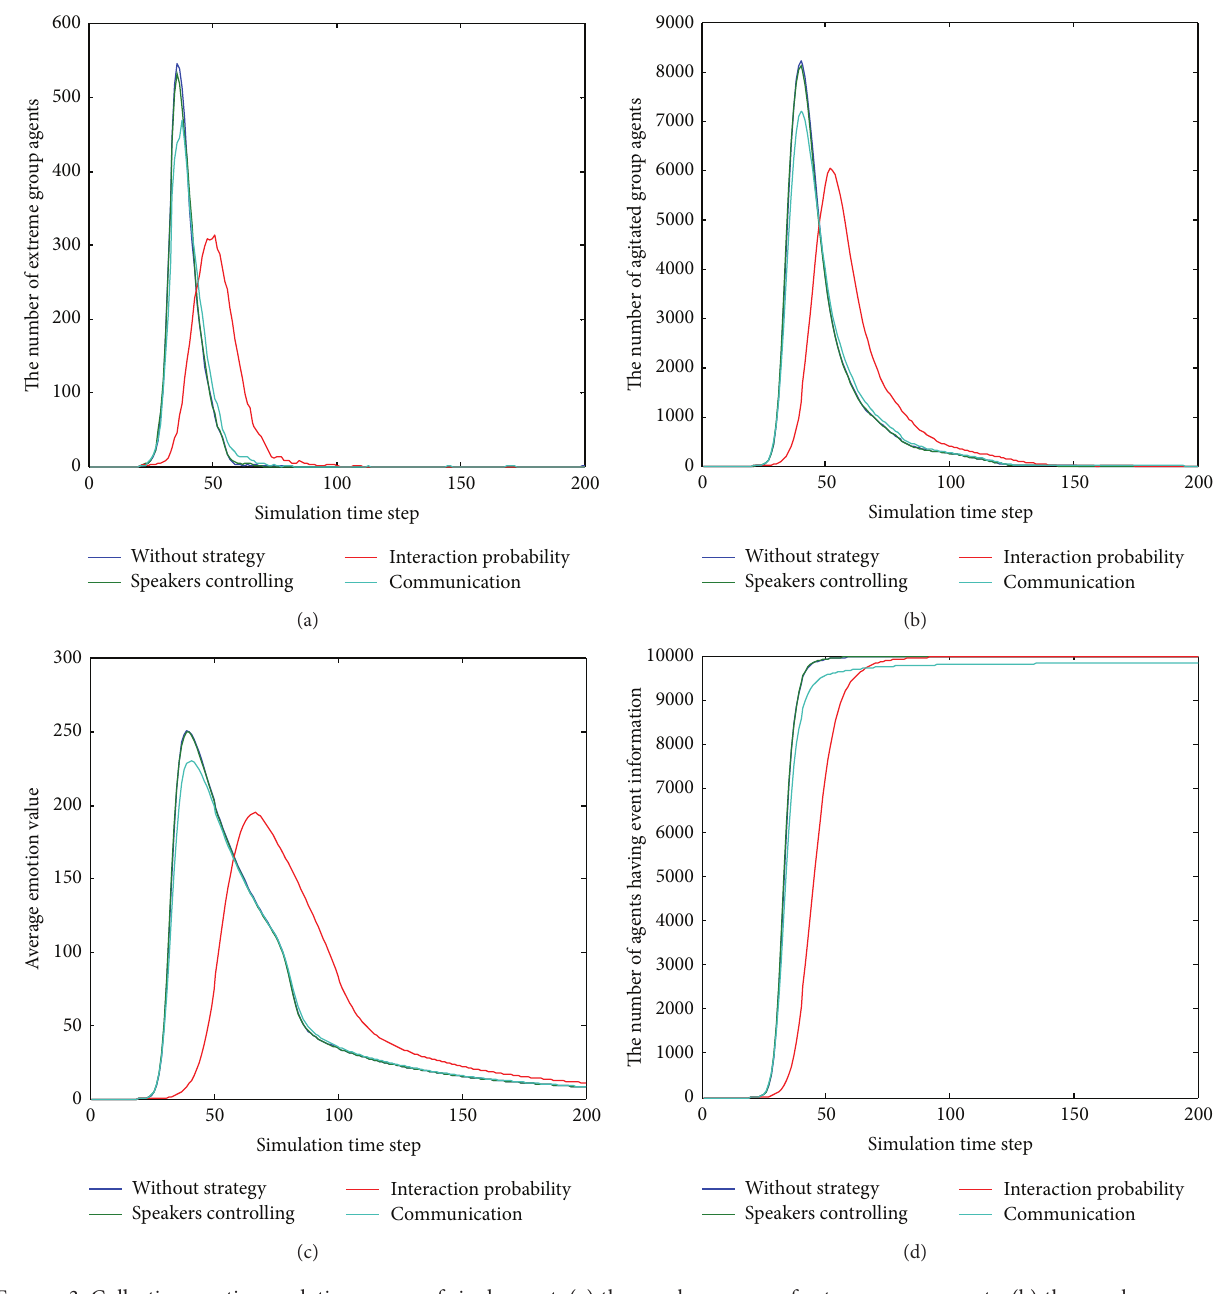
Figure 3: Collective emotion evolution curves of single event, (a) the number curves of extreme group agents, (b) the number curves of agitated group agents, (c) average emotion value evolution curves, and (d) the information spreading process